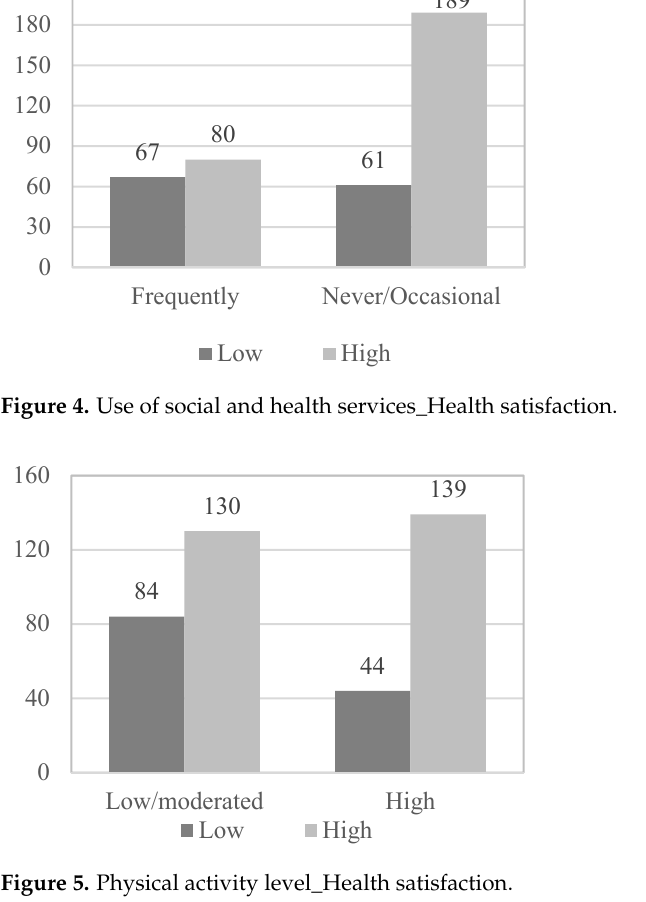
Figure 5. Physical activity level_Health satisfaction.